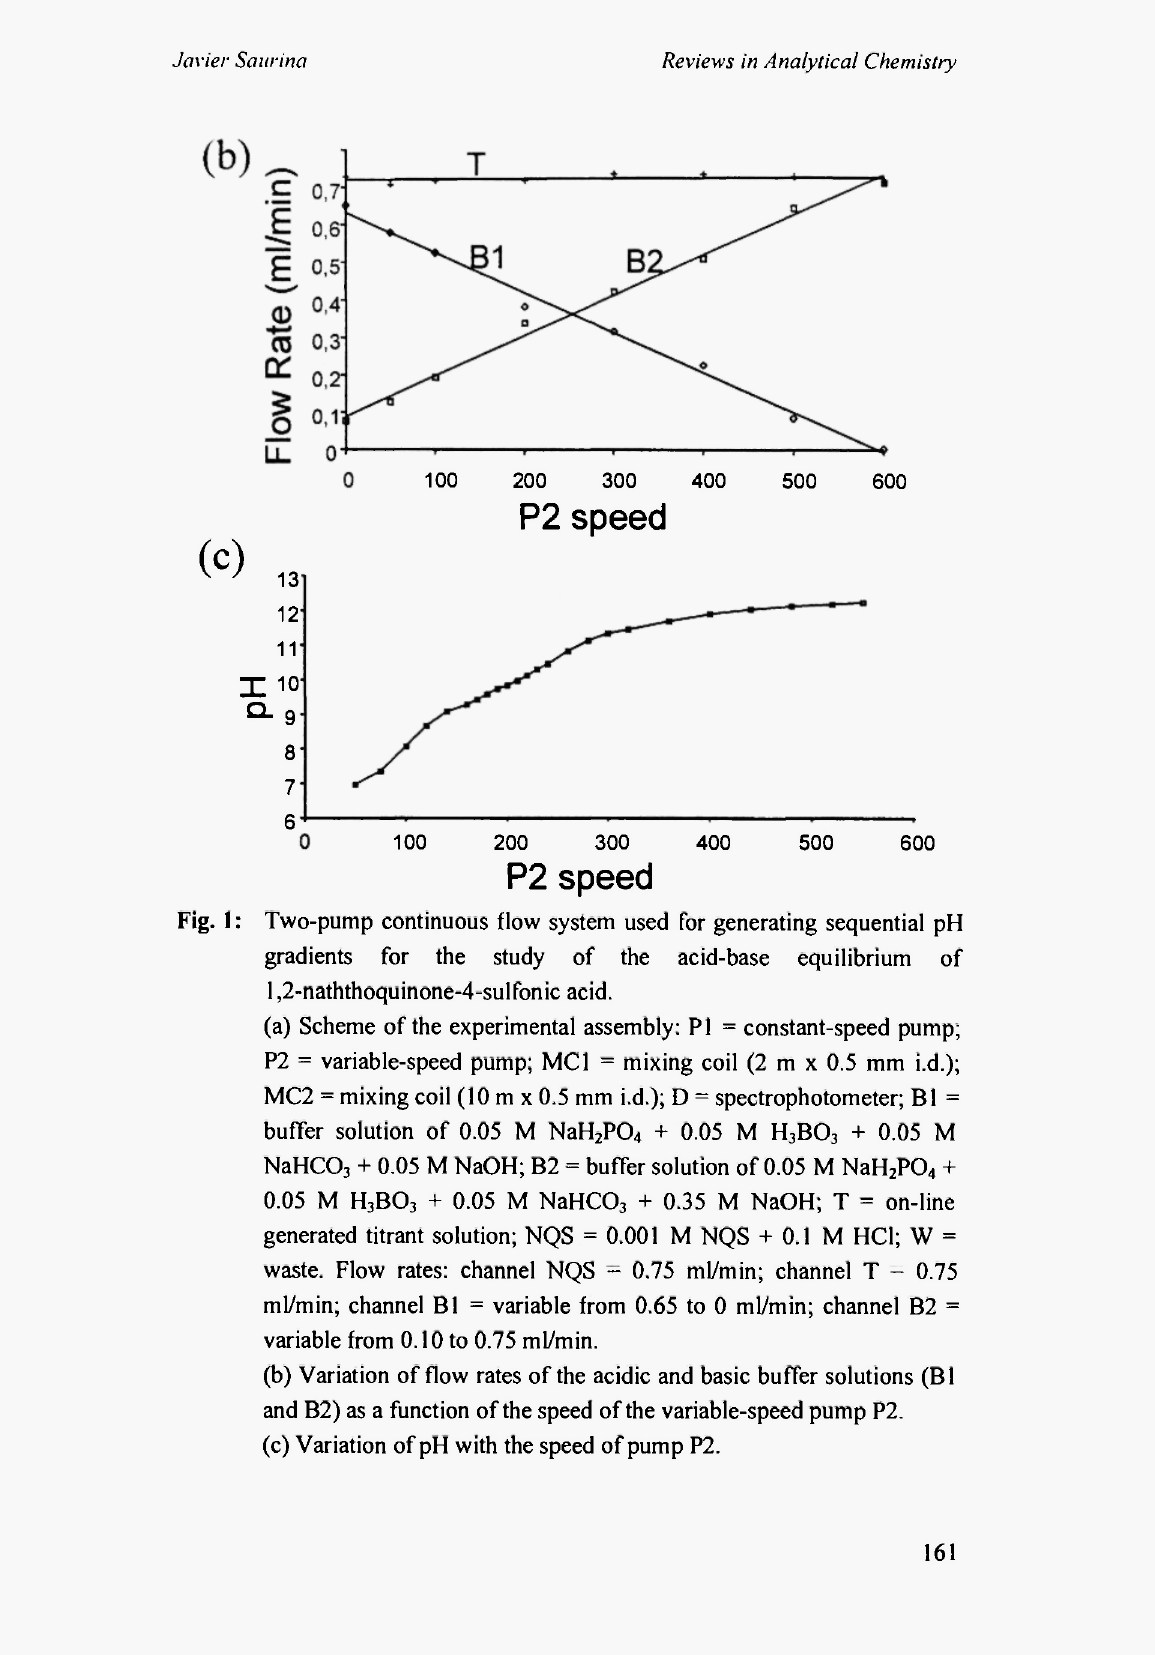
Fig. 1: Two-pump continuous flow system used for generating sequential pH gradients for the study of the acid-base equilibrium of l,2-naththoquinone-4-sulfonic